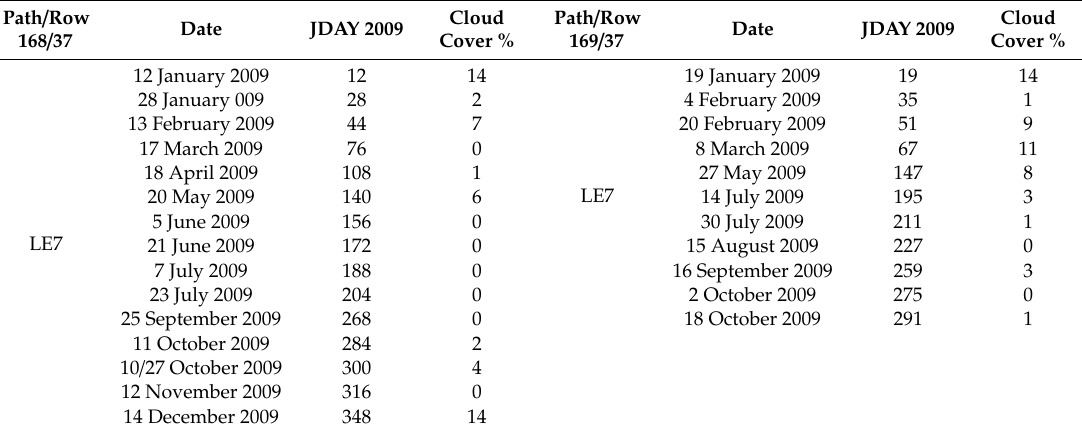
Table 3. Landsat images used to estimate T w in the Tigris River at